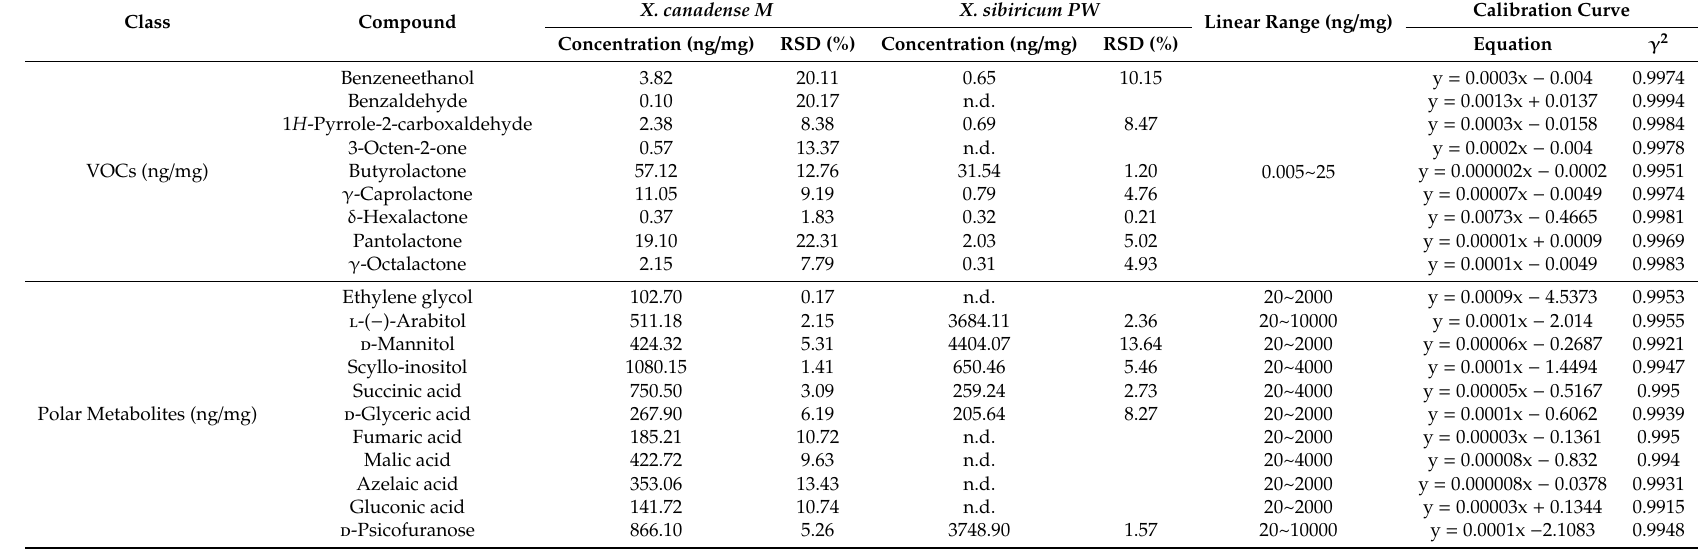
Table 1. Concentrations of chemical markers identified in Xanthii Fructus and their